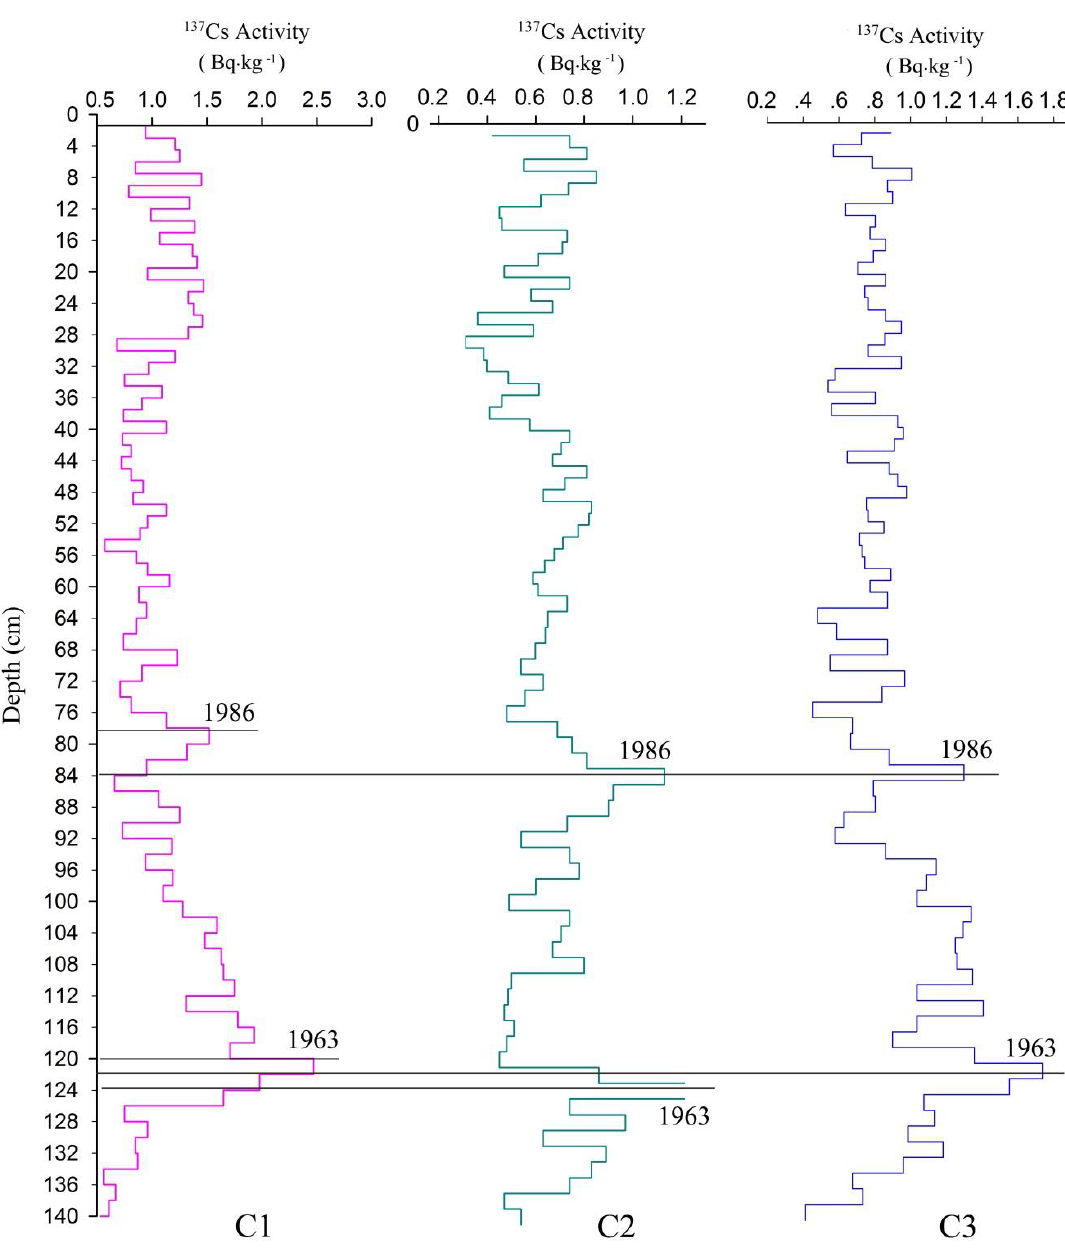
Figure 2. The dating analysis results of 137 Cs.